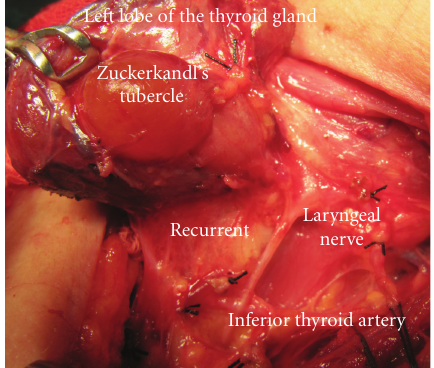
Figure 2: Left side of the same patient; the left Zuckerkandl’s tubercle is present as posterior extension of the left lateral lobe. The recurrent laryngeal nerve is at usual